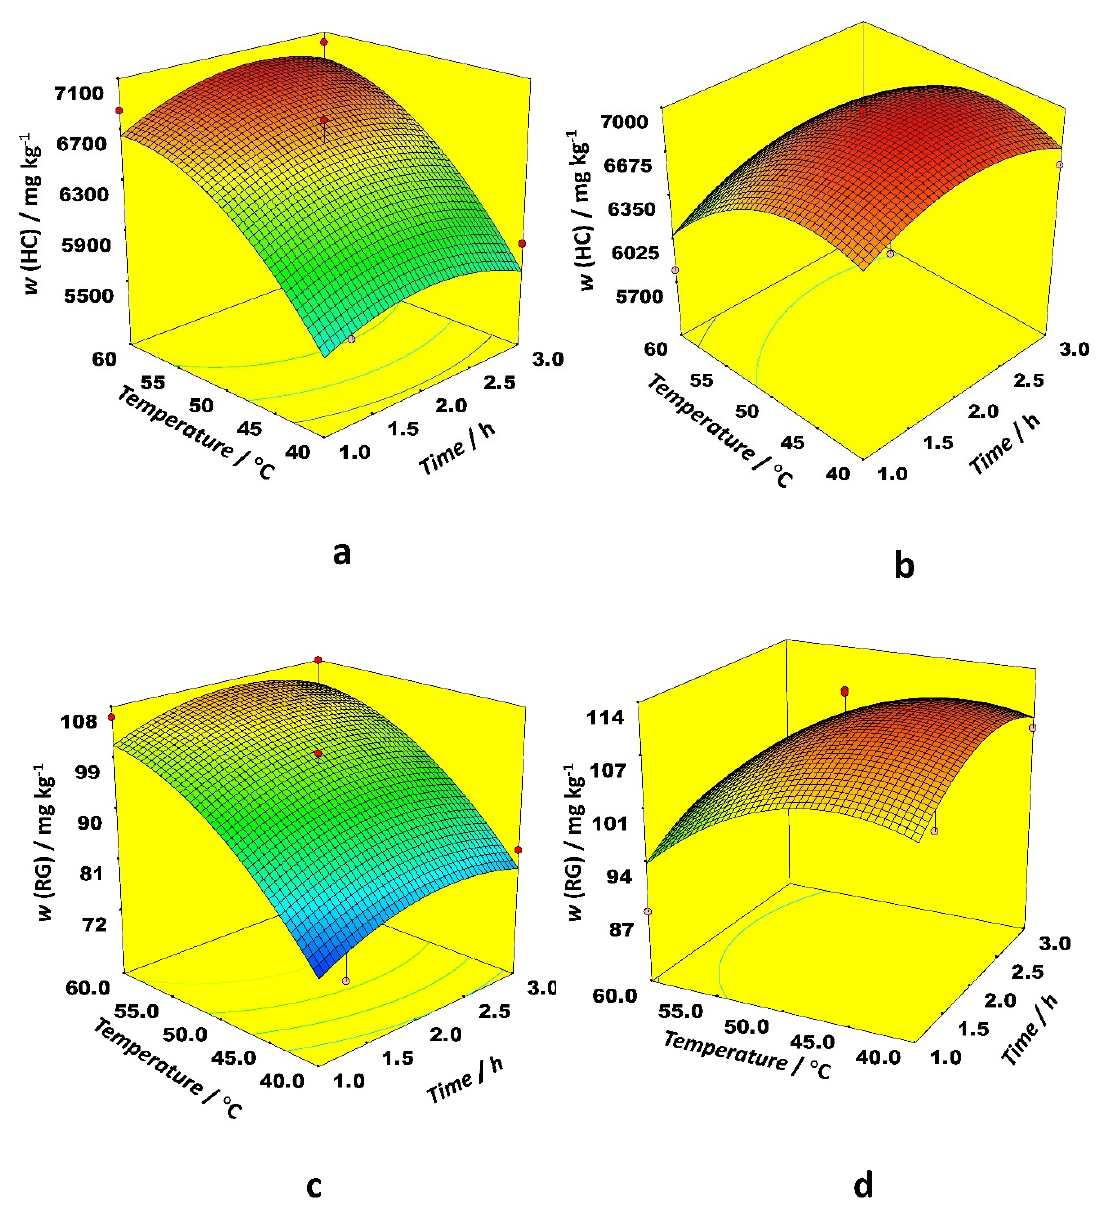
Figure 3. 3D-response surface plots of the most prominent interaction factors for hydroxycinnamic acids extracted from grapevine leaves using ethanol and acetonitrile (subfigures a and b ) and for resveratrol-3- O - glucoside using ethanol and acetonitrile (subfigures c and d ) as organic modifiers. Among linear effects in the case of the HB, only the sample weight was statistically significant, while the other ones had a negligible effect. The effect of interaction between time and temperature on HB content was different for ethanol and acetonitrile as the organic modifier. When ethanol was applied as a modifier, the highest HB content was obtained at low temperatures and longer extraction times. The modest temperatures and long extraction time positively affected extraction efficiency with acetonitrile as a modifier (Figure 4).